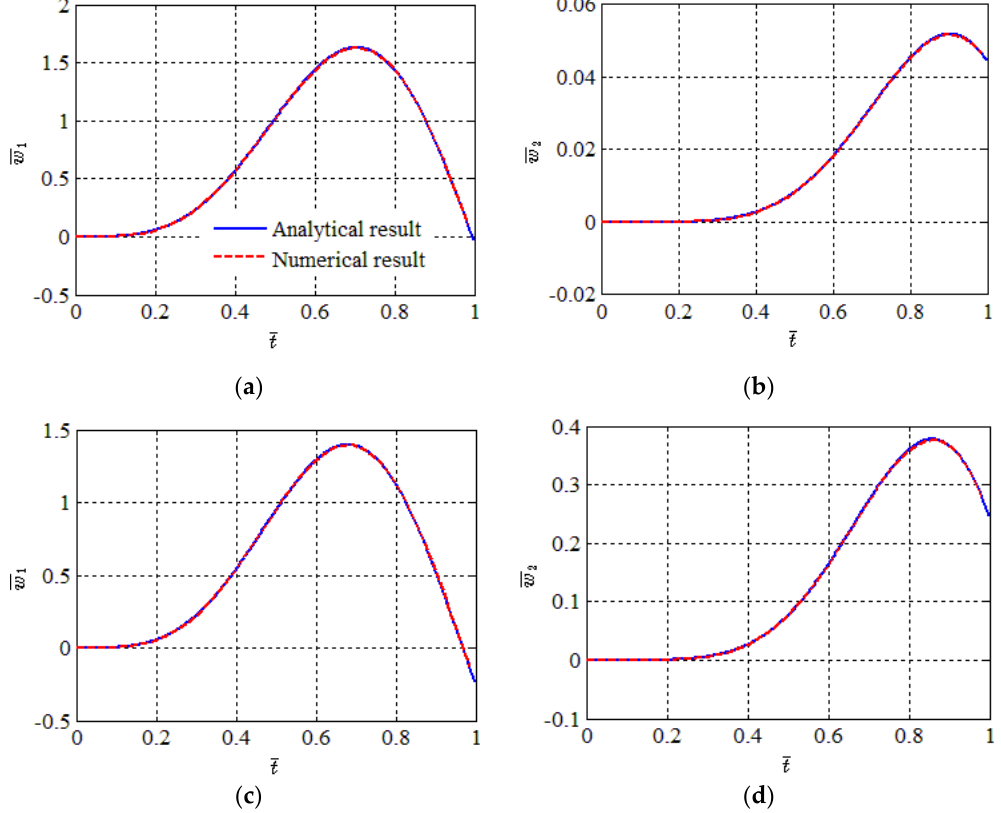
Figure 12. Comparison between analytical results and numerical results for α = 0.5 , ( a , b ) s e = 10 , ( c , d ) s e = 100 .